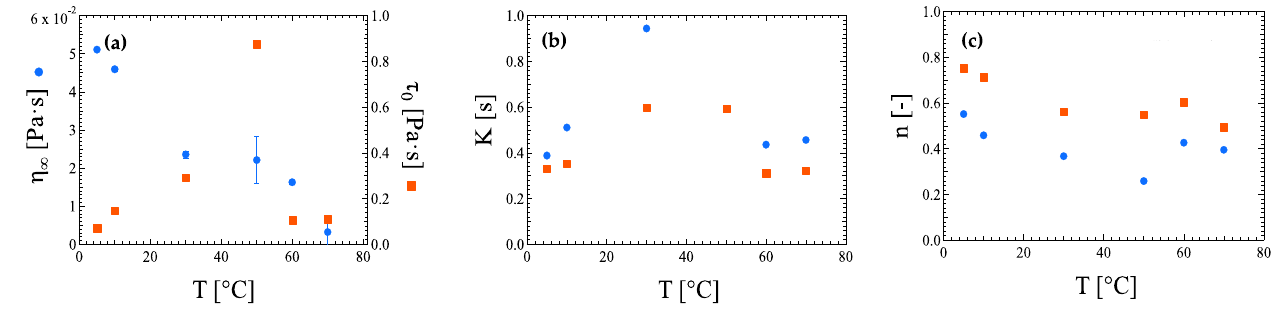
Figure 8. Comparison between Sisko equation (circle) and Herschel–Bulkley model (square) fitting parameters with error bars of ( a ) infinity-shear viscosity η ∞ and zero-shear stress τ 0 , ( b ) flow consistency index K , and ( c ) flow behavior index n for ink suspensions with 0.80 wt% HRCM load.